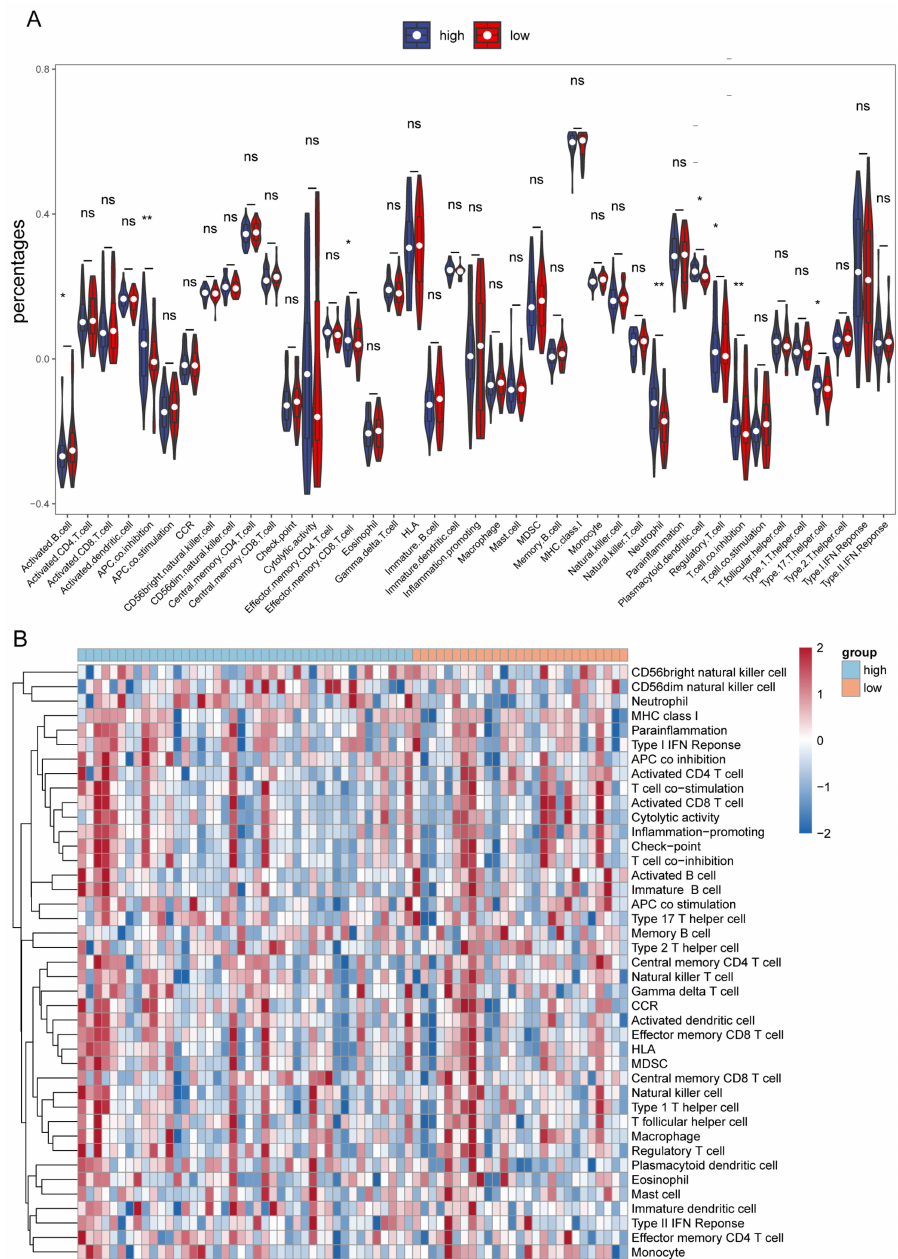
Figure 5. ssGSEA analysis in high- and low-risk groups. ( A ) The violin plot of immune scores of immune cell types in high- and low-risk groups. ( B ) Heat map of immune scores of immune cell types in high- and low-risk groups. * represents p < 0.05, ** represents p < 0.01, ns represents no significant